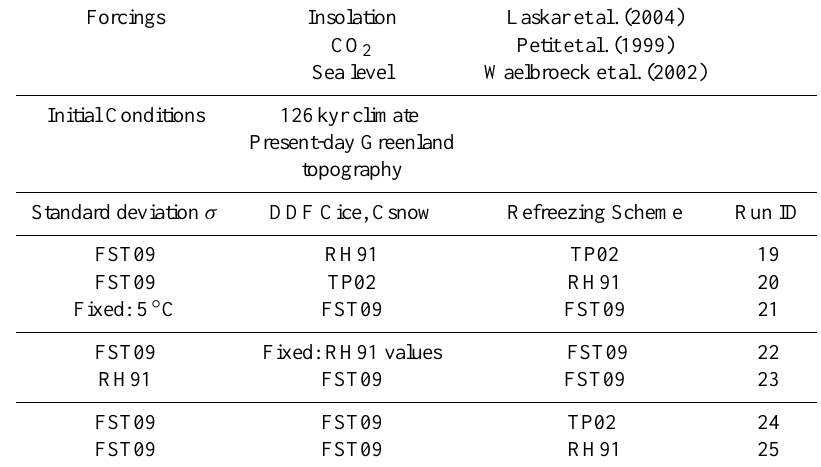
Table 3 . Sensitivity experiments to PDD parameters.